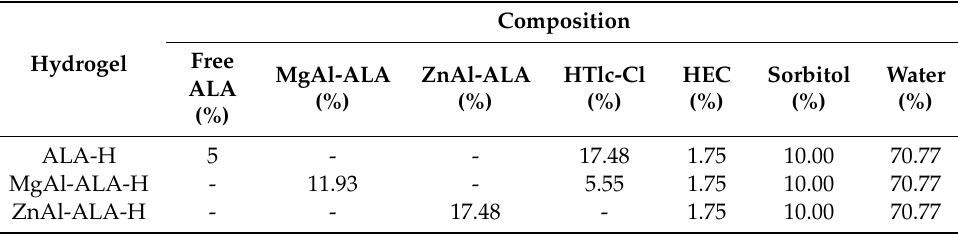
Table 2. Compositions of the hydrogels